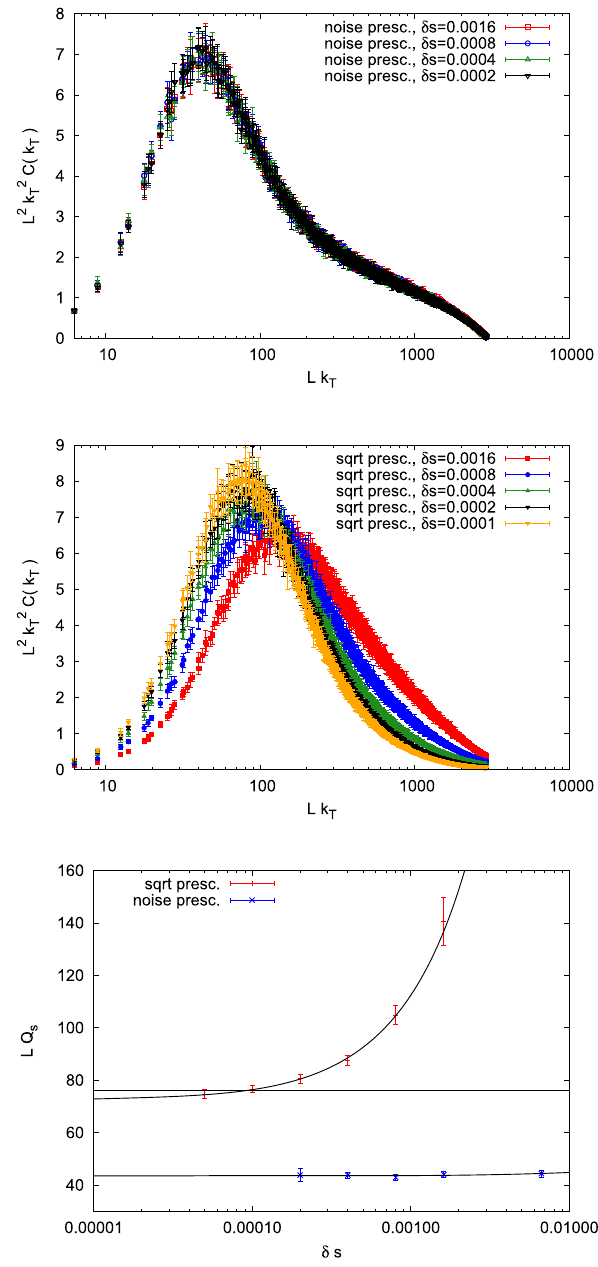
Fig. 12 Comparison of gluon densities obtained with the “noise” (top) and “square root” (middle) prescriptions for α s as a function of the Langevin step size at rapidity s = 0 . 16. Bottom: vanishing step size extrapolation of the saturation scale Q s determined from the max- ima of the distributions. We used a simple fit ansatz of the form LQ s (δ s ) = b + c δ s , with b and c being fit parameters. One sees a dramatic difference in the convergence rate: the “noise” prescription is roughly insensitive to the step size in the investigated range, whereas the “square root” prescription exhibits a linear slope similar to the one found in the fixed coupling setting. A constant fit to the two finest step sizes ( δ s ≤ 0 . 0001) for the “square root” data was also performed, showing that the continuum limit has been attained. The data set cor- responding to the finest step size, δ s = 0 . 00005 is not shown on the middle panel, as it overlaps almost ideally with δ s = 0 .